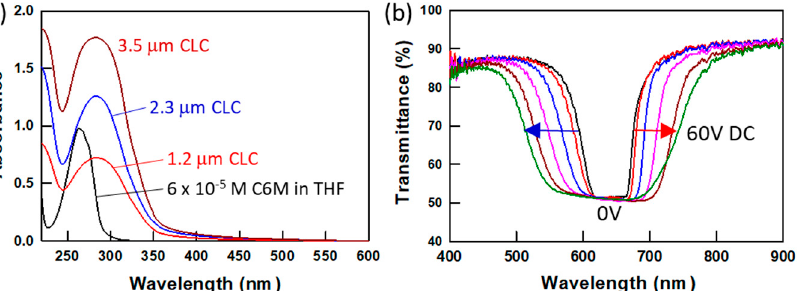
Figure 2. ( a ) Absorbance of 6 × 10 − 5 M C6M in THF, and CLC mixture formulated with 5 wt% as- received C6M, 5 wt% R1011, 5 wt% R811 and 85 wt% E7 in 1.2 μ m, 2.3 μ m, 3.5 μ m thickness KBr pellets and ( b ) bandwidth broadening of 15 μ m thick PSCLC by increasing a DC voltage from 0 V to 60 V DC. The PSCLC is prepared from the CLC mixture containing 5 wt% C6M, 5 wt% R1011,